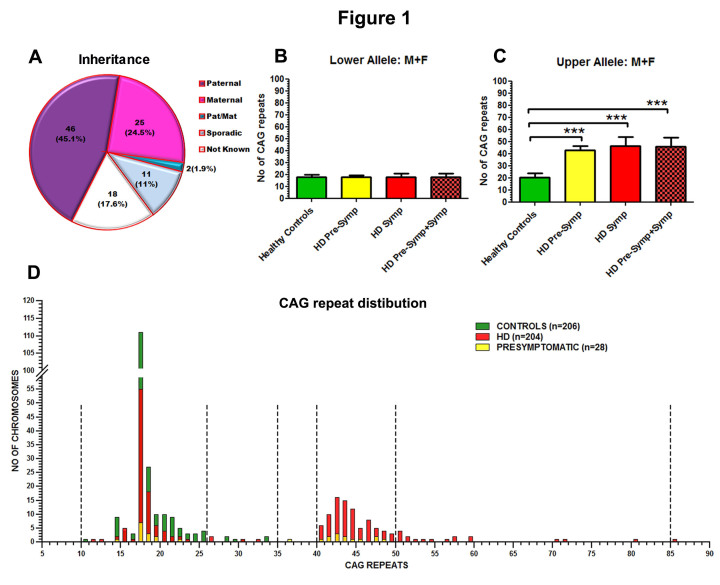
Fig.1A: Mode of inheritance based on detailed clinical interviews of symptomatic HD individuals and family members. Number of individuals (%) Fig.1B: Distribution of CAG repeats at the lower allele (LA) in healthy controls, HD symptomatic and pre symptomatic individuals. Fig.1C: Distribution of CAG repeats at the upper allele (UA) in healthy controls, HD symptomatic and pre symptomatic individuals. *** p≤0.001 Fig.1D: The CAG distribution in the Indian population shows a pattern of 5 distinct spreads.